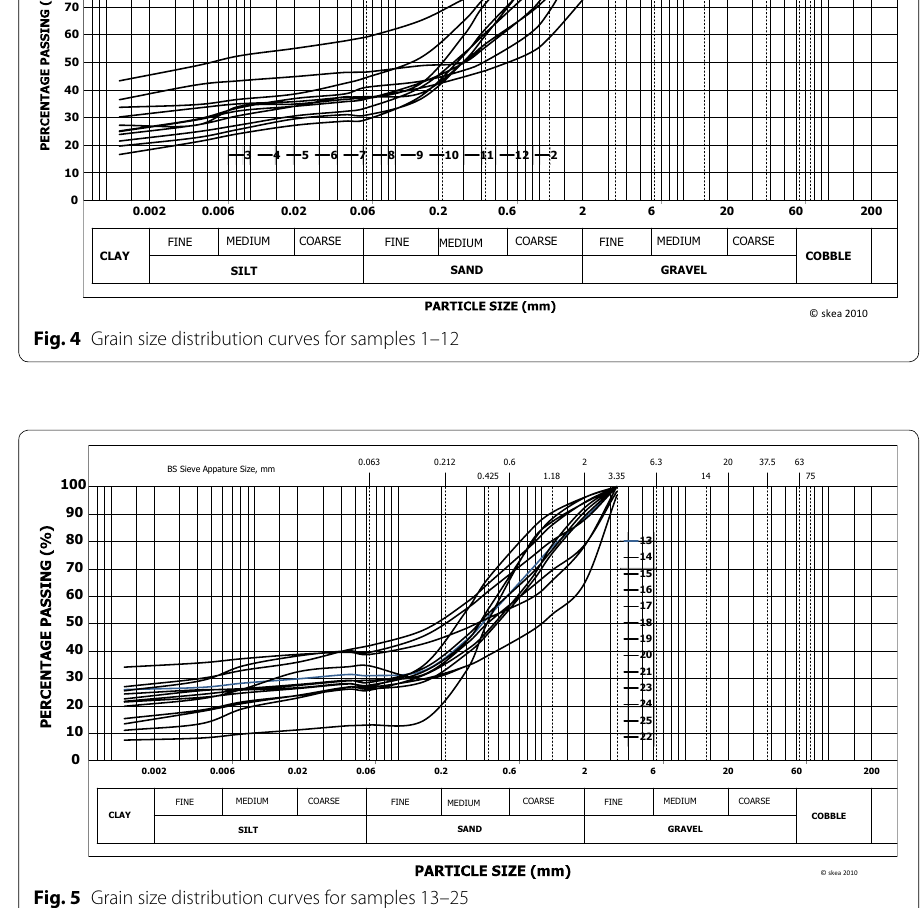
Fig. 5 Grain size distribution curves for samples